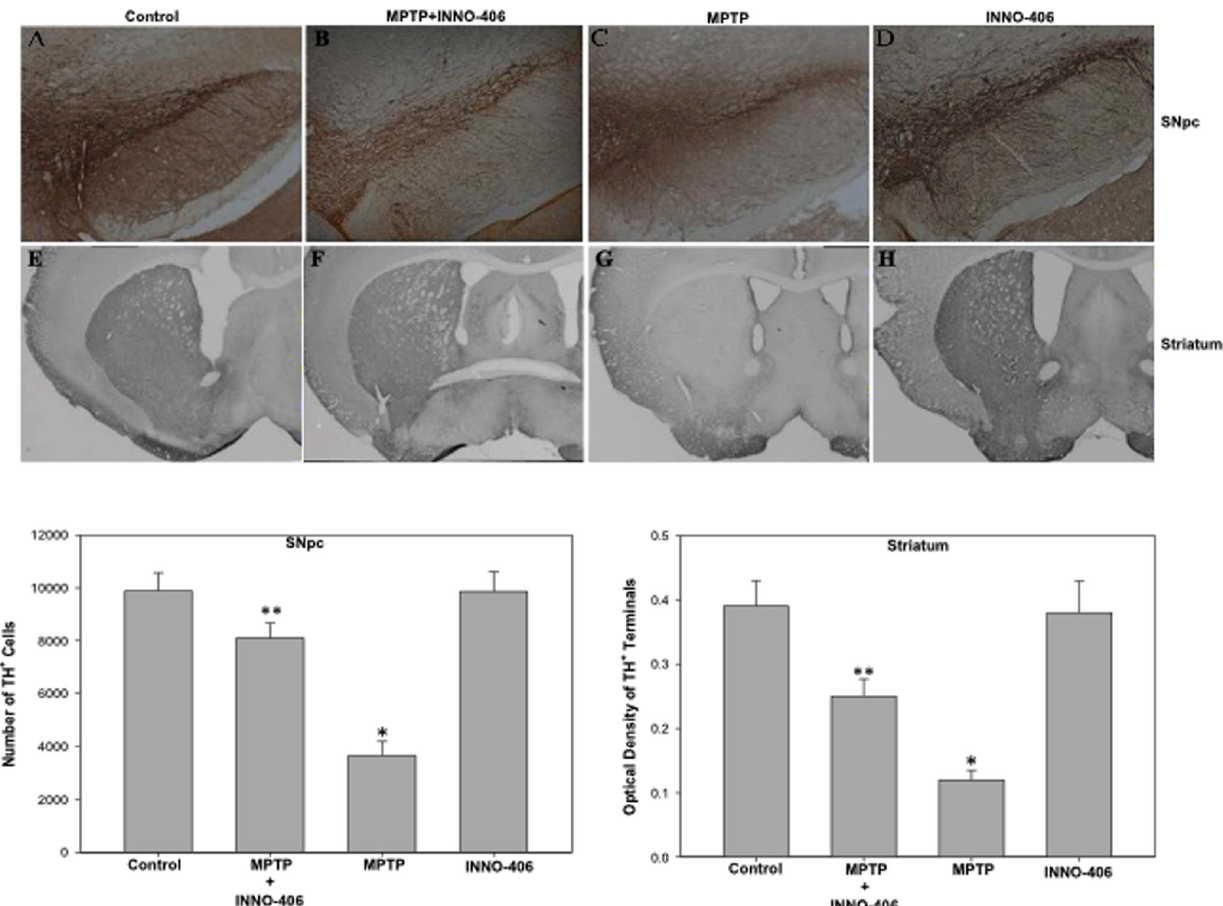
Figure 3. The c-Abl inhibitor INNO-406 protects against MPTP-induced loss of DA neurons. INNO-406 (10 mg/kg/i.p for one week prior to MPTP, 4 6 20 mg, and one week after MPTP treatment) protects (A–D) substantia nigra DA neurons and (E–H) striatal DA terminals from MPTP- induced toxicity. Pre-treatment of mice with INNO-406 leads to preservation of TH + positive staining cells within the substantia nigra pars compacta and DA terminals in the striatum compared to MPTP treatment alone. Plots of quantitative stereological data showing the protective effect of INNO- 406 in SNpc and striatum has been shown. * Considered statistically significant from control (p , 0.05). ** Considered statistically significant from MPTP (p , 0.05). SNpc=Substantia Nigra pars compacta